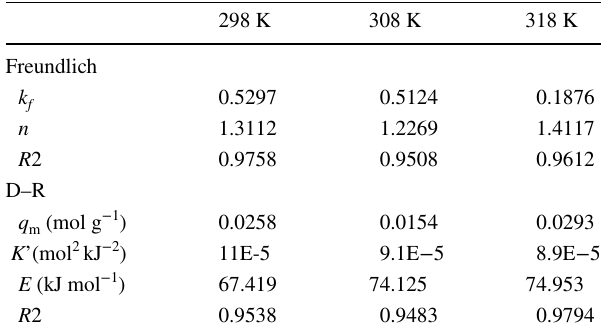
Table 4 Isotherm model parameters and correlation coefficients for the biosorption of MB onto the